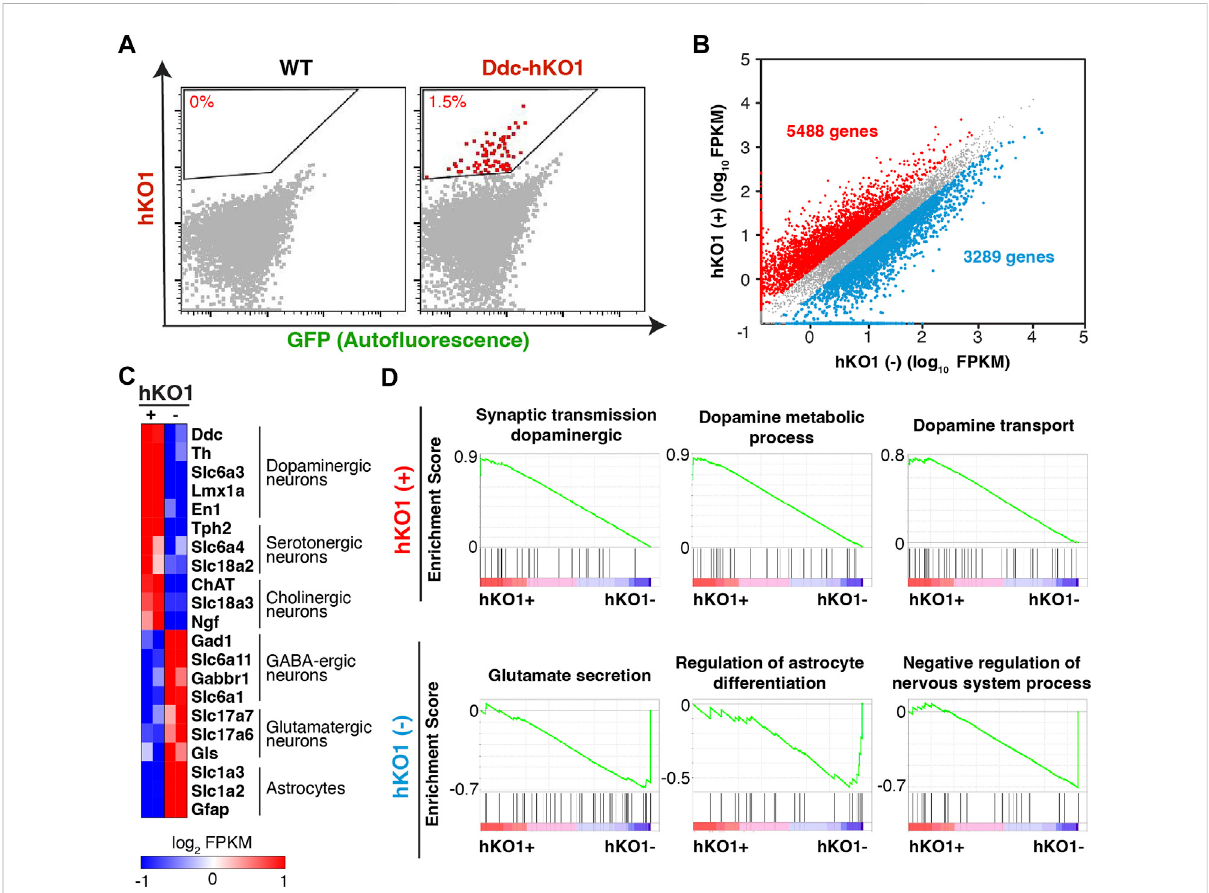
FIGURE 3 Puri fi cation of dopaminergic neurons from Ddc-hKO1 homozygous mouse. (A) Representative FACS dot plots showing the gating strategy for the recovery of hKO1-positive neurons from Arc, VTA, SNc, DR, RRF, and LC of WT and Ddc-hKO1 homozygous mouse brains. Red dots represent the hKO1-positive neurons. (B) Scatter plot of RNA-Seq gene expression data comparing hKO1-positive and hKO1-negative populations. Fold change (FC) > 2. Red dots indicate genes highly expressed in hKO1-positive neurons and blue dots indicate genes highly expressed in hKO1- negative cells. (C) Heat map representation of expression levels of selected neuronal and non-neuronal marker genes. (D) Representative gene set enrichment analysis (GSEA) results enriched in hKO1-positive and hKO1-negative